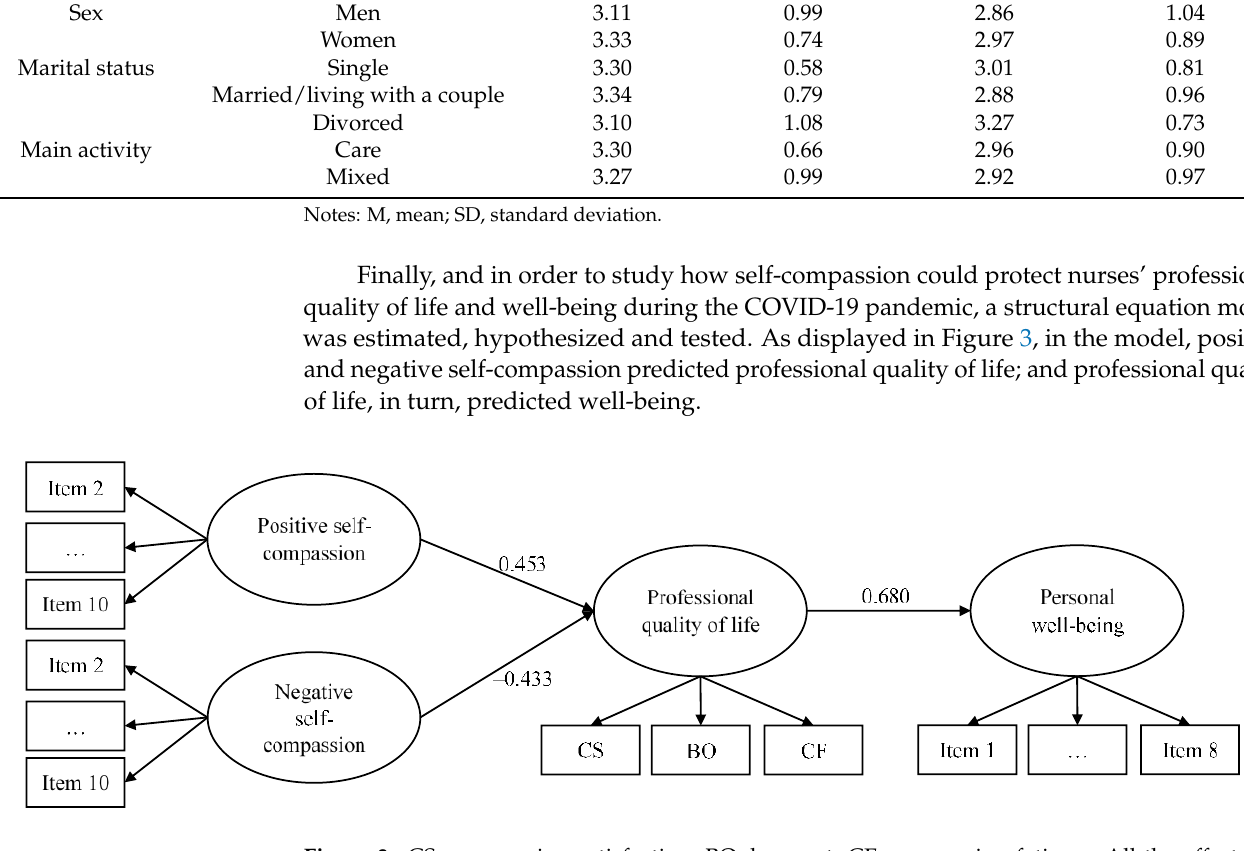
Figure 3. CS, compassion satisfaction; BO, burnout; CF, compassion fatigue. All the effects are statistically significant ( p < 0.001). Factor loadings can be consulted in Table 5. Table 5. Factor loadings of the SEM